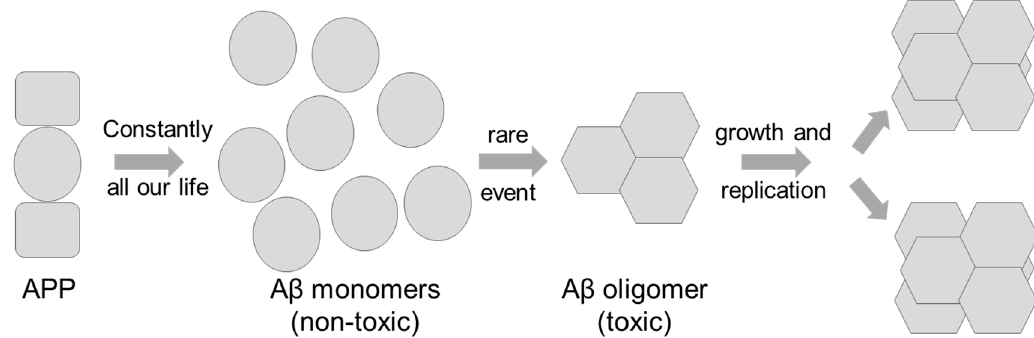
Figure 2. From left to right: Throughout our life time, A β monomers are constantly formed from the amyloid-beta precursor protein amyloid precursor protein (APP) by cleavage of beta- and gamma-secretases. Under physiological conditions (circa 1 nM A β ) the formation of a stable A β oligomer is a very rare event, because several A β monomers have to meet in one place at the same time. This is a high order reaction, which is extremely dependent on the A β monomer concentration (e.g., to the sixth power). For rare things to happen, however, one only needs to wait long enough, explaining why life age is the most important risk factor for AD. Genetic disposition (familial AD cases and Trisomy 21) can lead to higher A β concentrations, making the formation of the first oligomer seed more likely to happen and thus occurs earlier in life. Once the first A β oligomer seed has been formed, it can further grow by consecutively consuming one A β monomer after the other. This is a kinetically favored first order reaction with a rate much less dependent on the A β monomer concentration. A β oligomers can break into smaller assemblies that grow again by consuming A β monomers. This is nothing else than a replication competent A β assembly containing A β monomer subunits in defined conformation, which is different from the intrinsically disordered native A β monomer conformation. In the scheme, different shapes symbolize different conformations of A β . For the sake of simplicity, the possibility of different A β assembly species containing A β monomers in even more different defined conformations has not been included in the scheme. This would be analogous to the concept of different existing prion strains with different properties. Please note that also the concept of secondary nucleation, which describes the oligomer-assisted seed formation in the vicinity of pre-existing assemblies, has not been included in this over-simplified scheme.